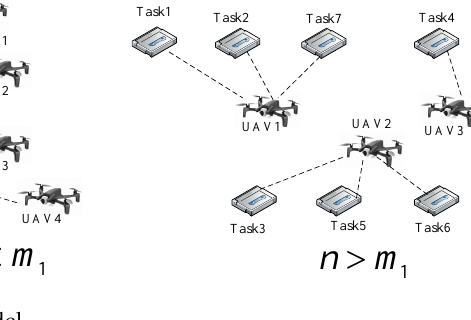
Figure 3. UAV task assignment model.